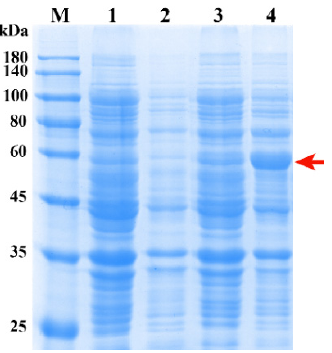
Figure 7. SDS-PAGE electrophoresis of prokaryotic expression of pET28a- UGT84A77 . M, Protein Marker; lane 1, pET28a without isopropyl- β - D -thiogalactopyranoside (IPTG); lane 2, pET28a, induced by 0.2 mM IPTG; lane 3, pET28a-UGT84A77 without IPTG; lane 4, pET28a-UGT84A77, induced by 0.2 mM IPTG; the arrow indicates the expressed fusion protein, approximately 57